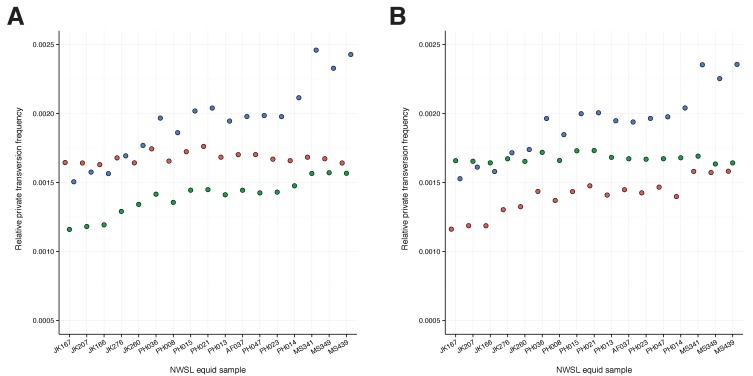
A comparison of relative private transversion frequencies between the nuclear genomes of a caballine Equus (horse, E.caballus; green), a non-caballine Equus (donkey, E. asinus; red), and the 17 New World-stilt legged (NWSL) equid samples (=Haringtonhippus francisci; blue), using approach three (Appendix 1), with samples ordered by increasing mean mapped read length. Analyses are based on alignment to the horse (A) or donkey (B) genome coordinates.